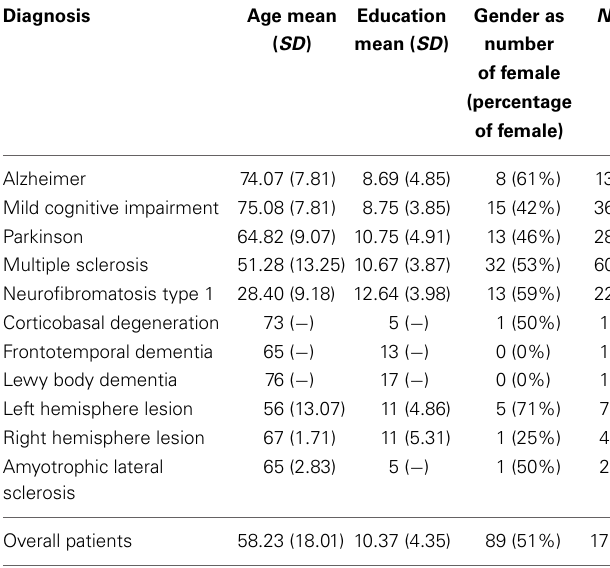
Table 1 | Demographic variables of the patient group. Table 2 | Reliability of